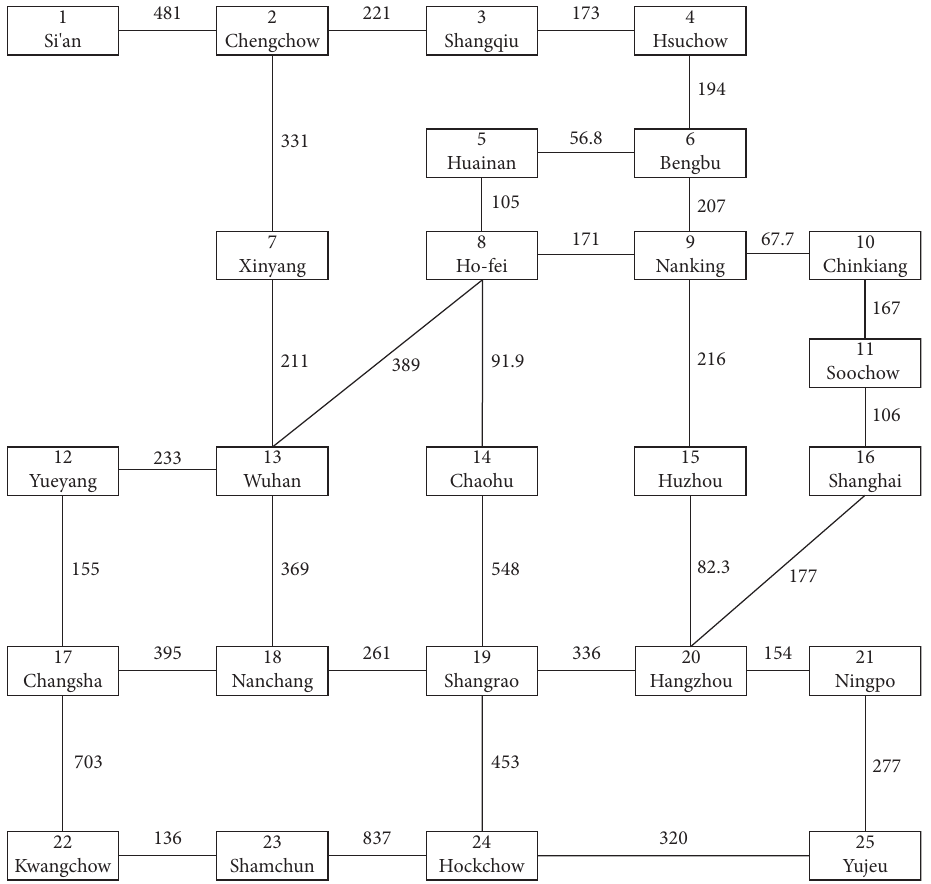
Figure 4: Diagram of the HSRN in Mid-Eastern